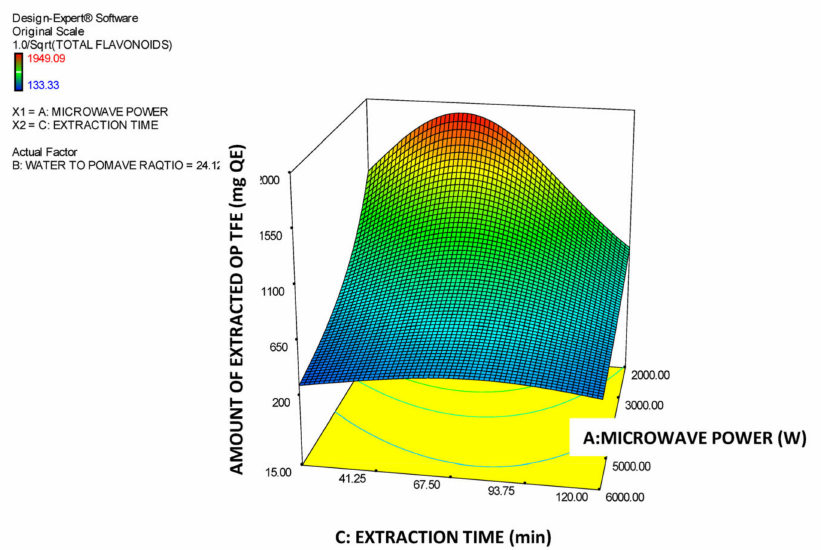
Figure 7. Response surface plot of the amount of extracted total OP flavonoids (TFE in mg QE) for the A × C interaction (A: Microwave power (W); C: Extraction time (min)).